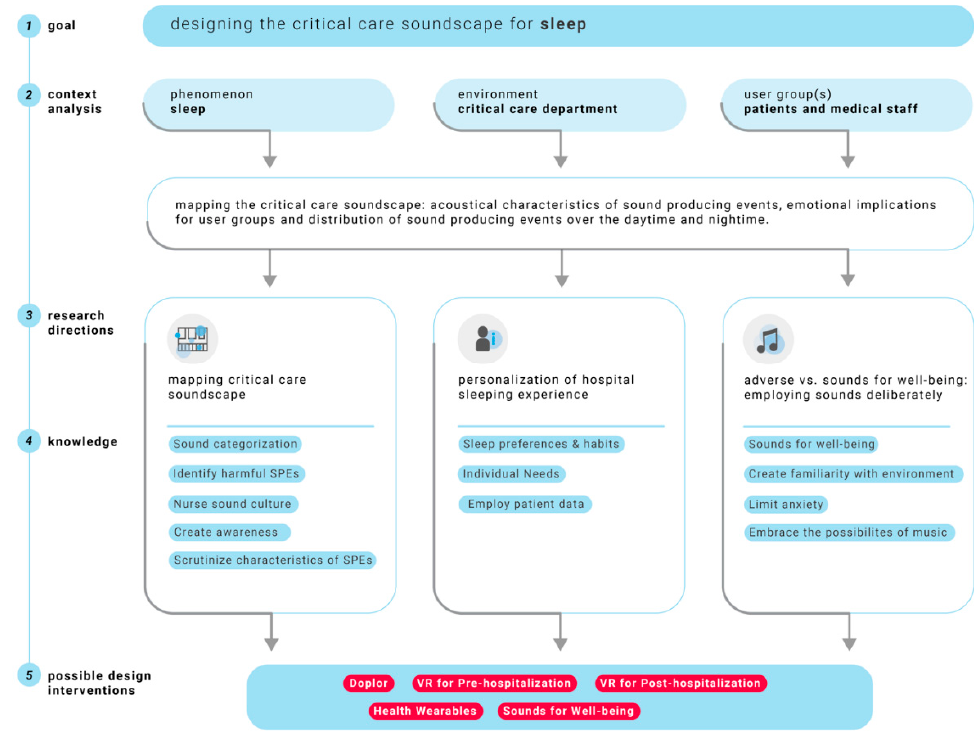
Figure 3. A five-phase strategy to improve the sleep experience in critical care environments.